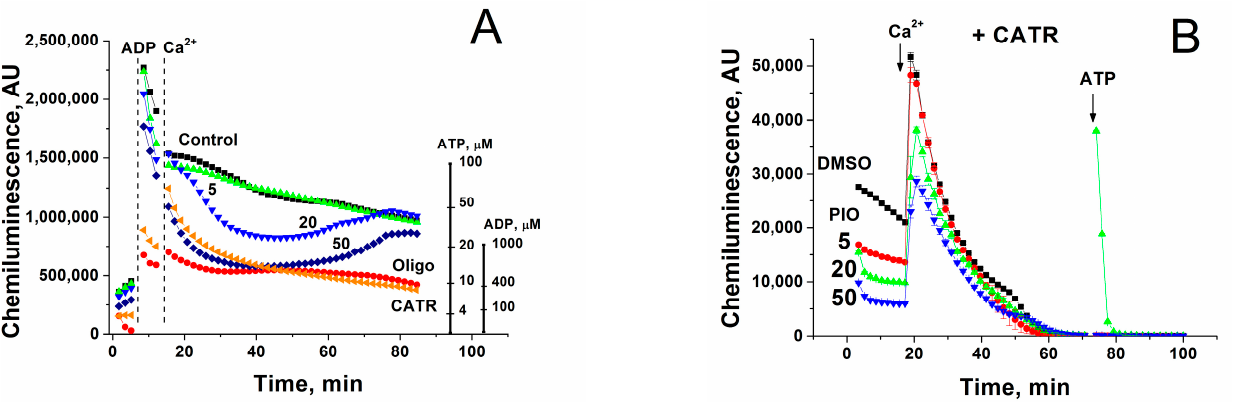
Figure 3. Effect of PIO on the capability of mitochondria to support ATP production in the presence of Ca 2+ ( A ) and on the level of matrix ATP ( B ). Mitochondria (0.2 ( A ) and 0.5 mg prot./mL ( B )) were placed in the standard incubation medium, which contained a 20% solution of a luciferin-luciferase reagent, 5 mM K + -succinate, 2 µg/mL of rotenone, 10 µM EGTA, and, where indicated, 5–50 µM PIO, 1 µM CATR, and 10 µg/mL oligomycin (Oligo). Vertical dashed lines ( A ) or arrows ( B ) show the addition of 500 µM ADP, 50 µM Ca 2+ , and 5 µM ATP standard (to calibrate the chemiluminescent signal). Representative data of three separate experiments are shown. Traces are the means for three wells.